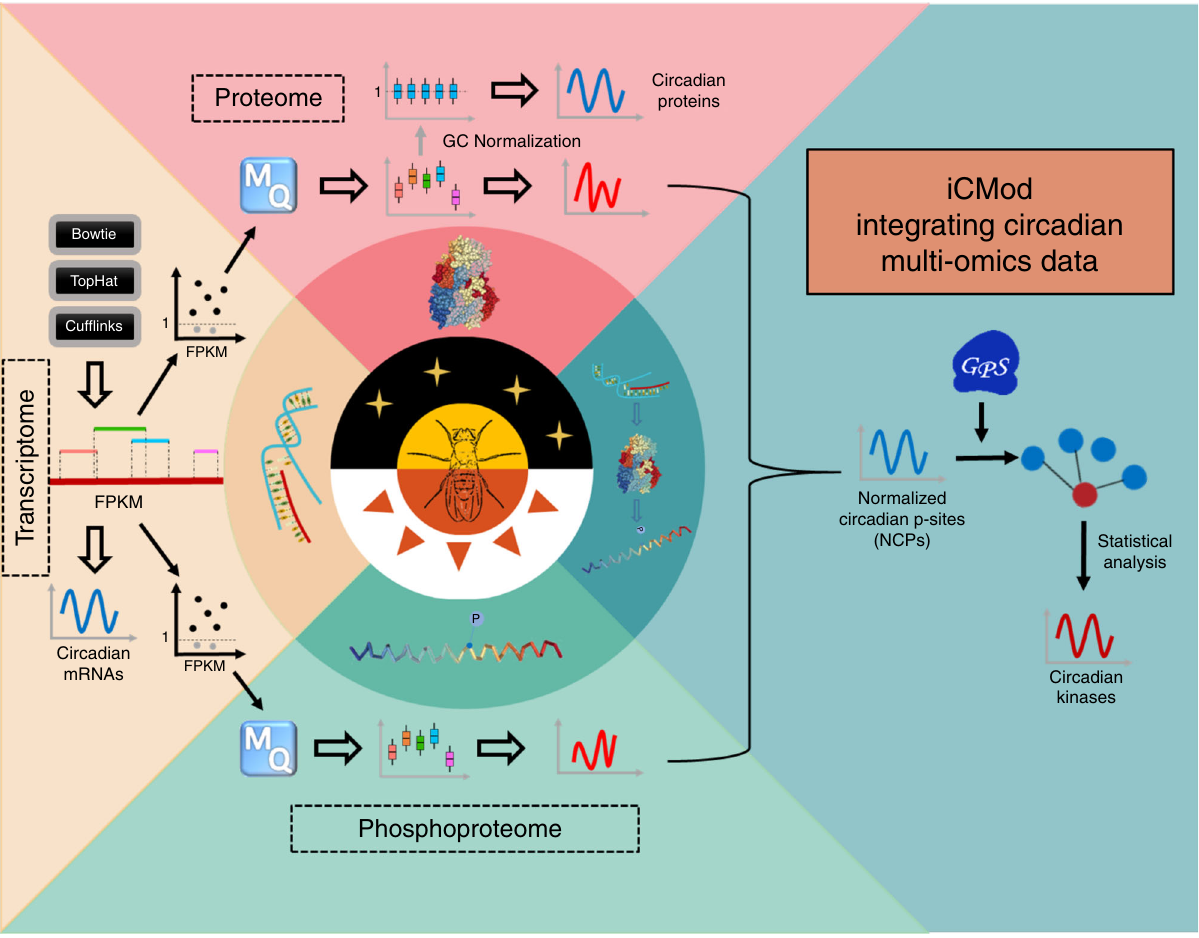
Fig. 2 The iCMod pipeline for analysis of multi-omics data and prediction of circadian protein kinases. We constructed a reference database for MS/MS searching containing only protein sequences with corresponding mRNA levels of FPKM ≥ 1 in at least one sample. After the database search for raw proteomic and phosphoproteomic spectra, the intensity values of proteins were normalized to one for each sample. Phosphorylation level was normalized to the corresponding protein level. ARSER was used to identify cycling mRNAs, proteins, and NCPs. GPS 2.1 was subsequently employed to predict ssKSRs, followed by a two-sided hypergeometric test to predict potential circadian